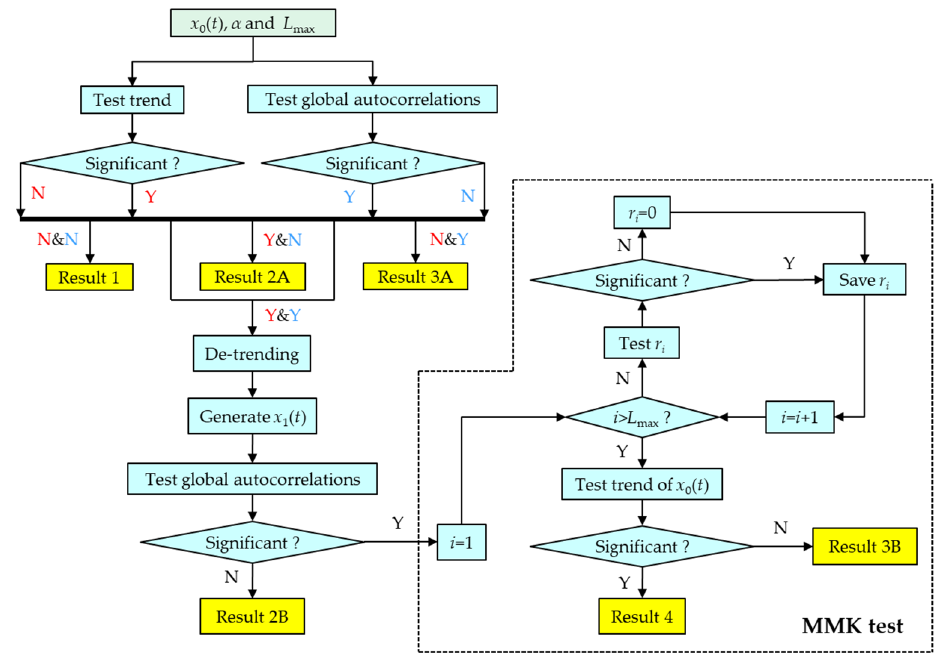
Figure 3. Trend test for an HCTS based on the MMK test. (Note: x 0 ( t ) denotes the original time series; x 1 ( t ) is the de-trended time series; Results 1, 2A, 2B, 3A, 3B, and 4 correspond to Scenarios 1, 2A, 2B, 3A, 3B, and 4, respectively; α is the significance level; L max denotes the maximum lag of autocorrelation coefficient; and r i represents the estimate of the i -th order autocorrelation coefficient.).